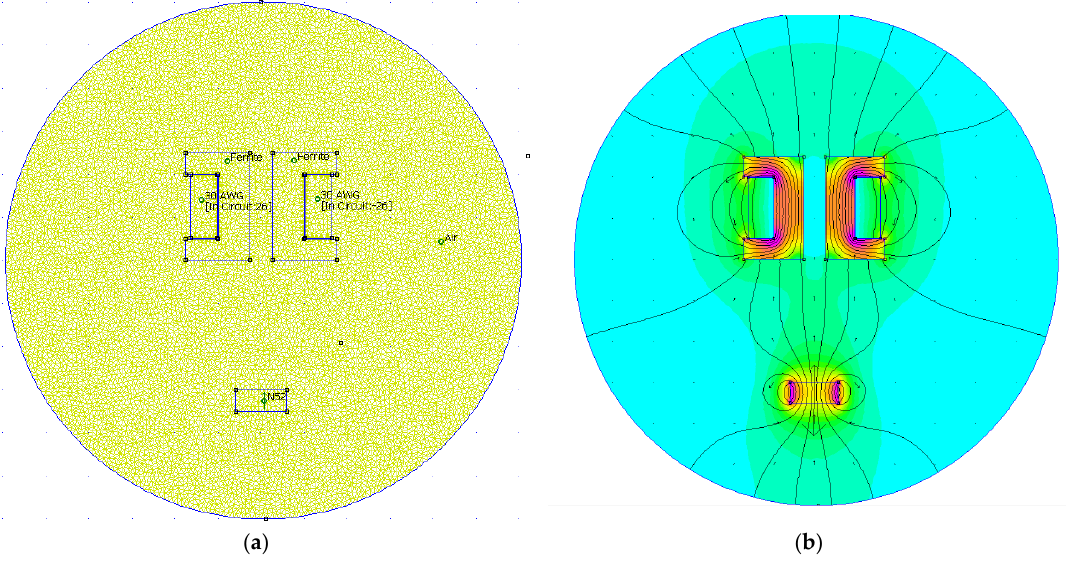
Figure 4. Finite element method with FEMM software for EMAwS. ( a ) Computational mesh; ( b ) Calculated values of magnetic force and field density.